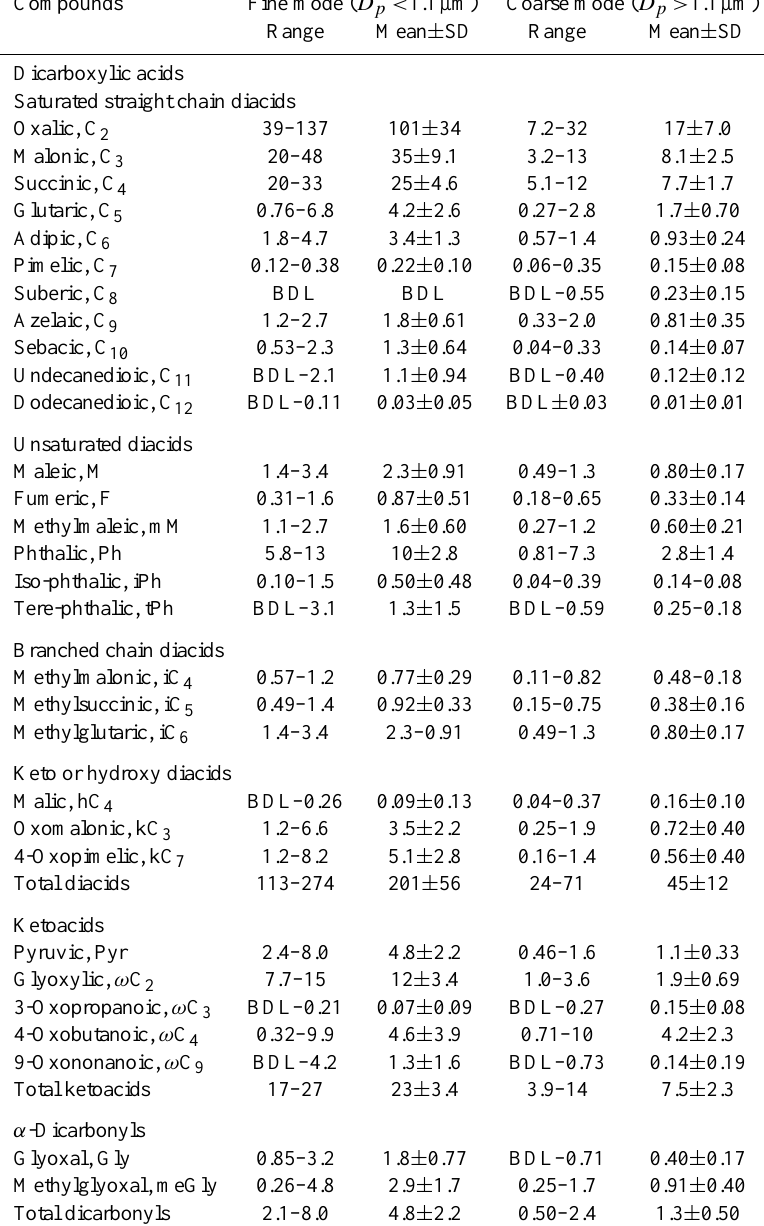
Table 2. Concentrations (ngm − 3 ) of dicarboxylic acids, ketoacids and dicarbonyls in the size-segregated aerosols from Sapporo, northern